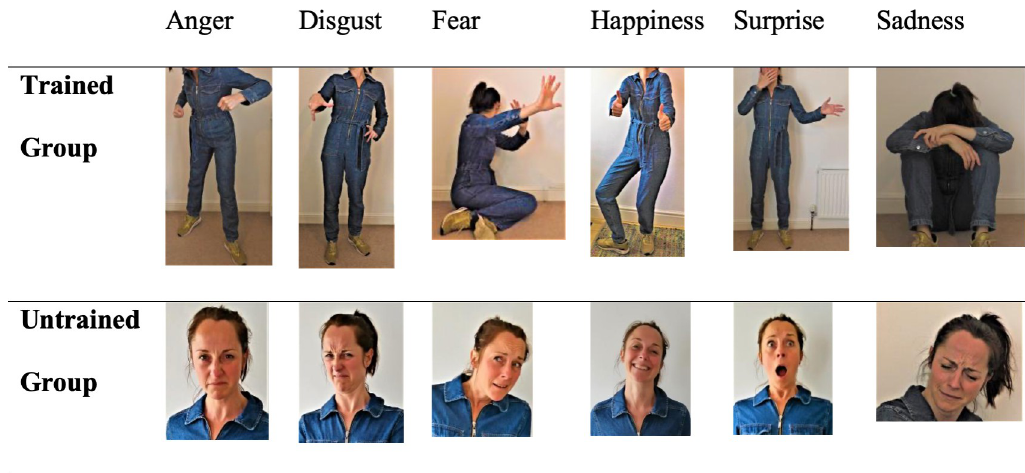
Fig 1. Stimuli. Differentiated Images shown to Trained and Untrained